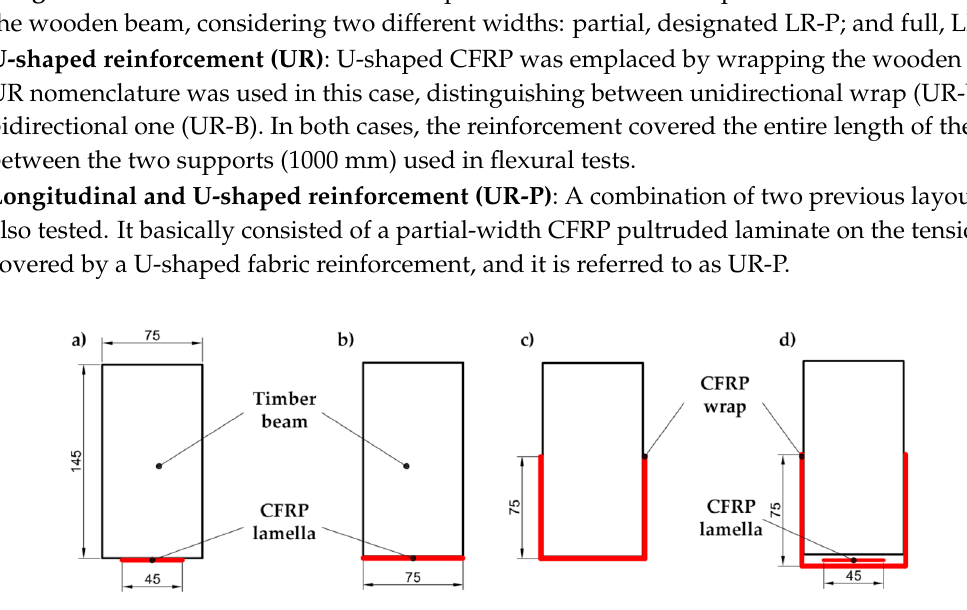
Figure 2. Reinforcement layouts: ( a ) Longitudinal reinforcement, partial width (LR-P); ( b ) Longitudinal reinforcement, full width (LR-F); ( c ) U-shaped reinforcement (UR); and ( d ) Longitudinal and U-shaped reinforcement (UR-P).